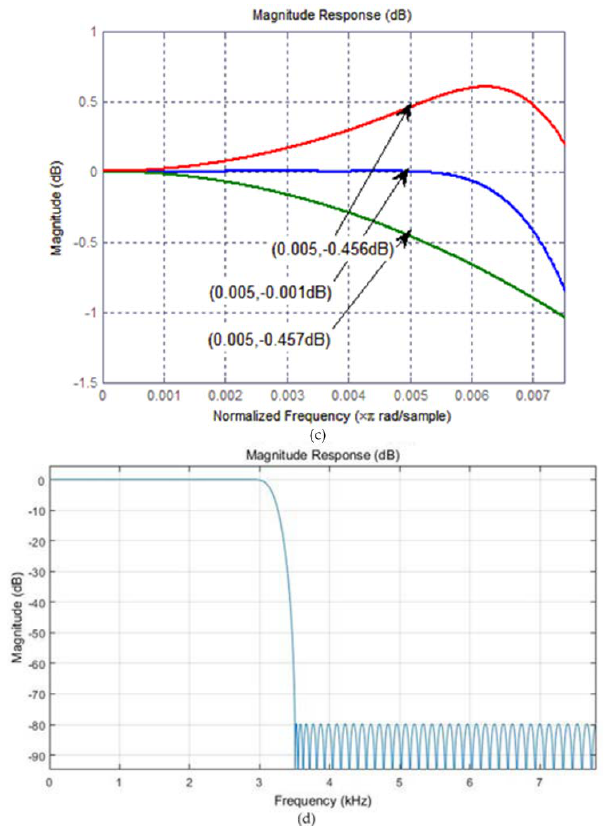
Figure 9. ( a ) Digital decimation filter model ( b ) Frequency response of first-stage cascade integral comb (CIC) filter ( c ) Passband amplitude response of CIC before and after compensation ( d ) Amplitude response of finite impulse response (FIR) low-pass filter.